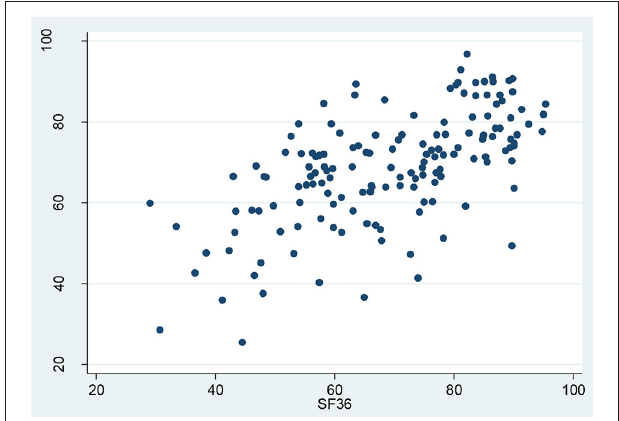
FIGURE 4 | Correlation between the overall health-related quality of life (HRQOL) scores of the KDQOL-36 and